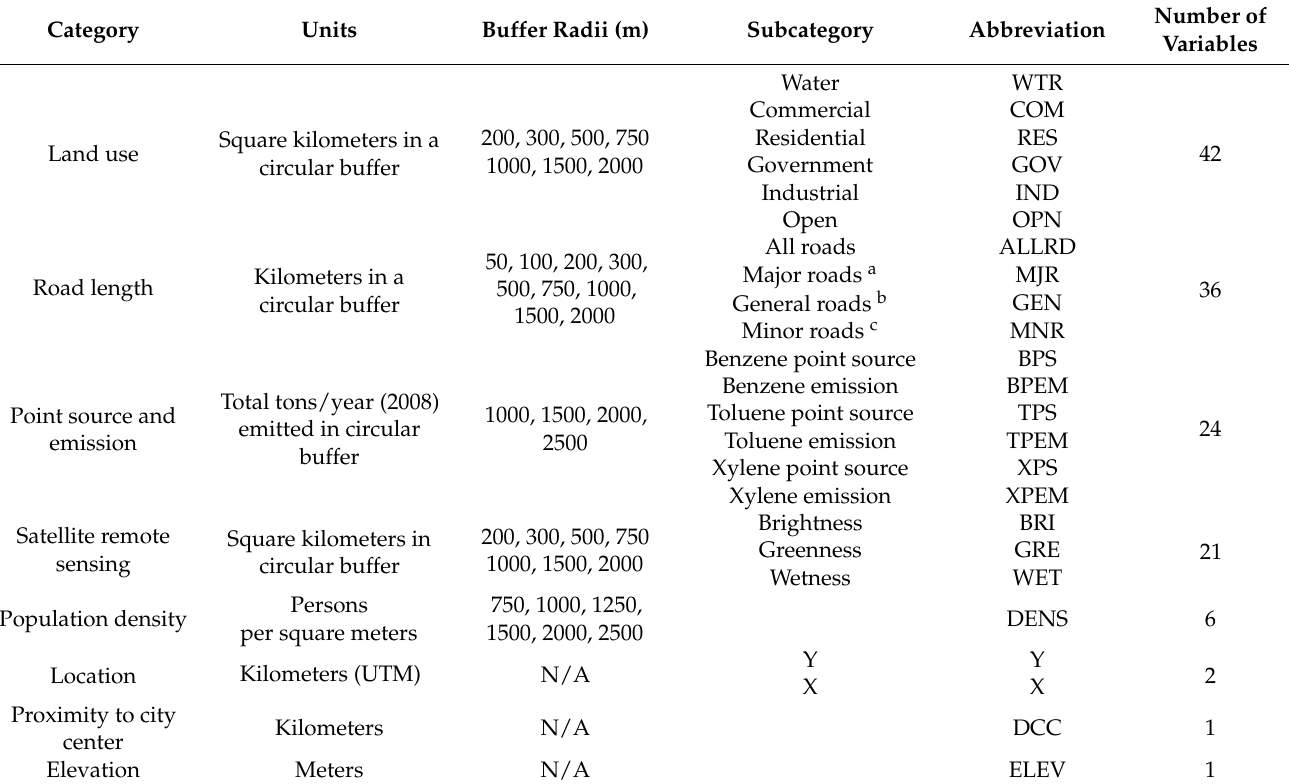
Table 2. Description of predictor variable categories for land-use regression model